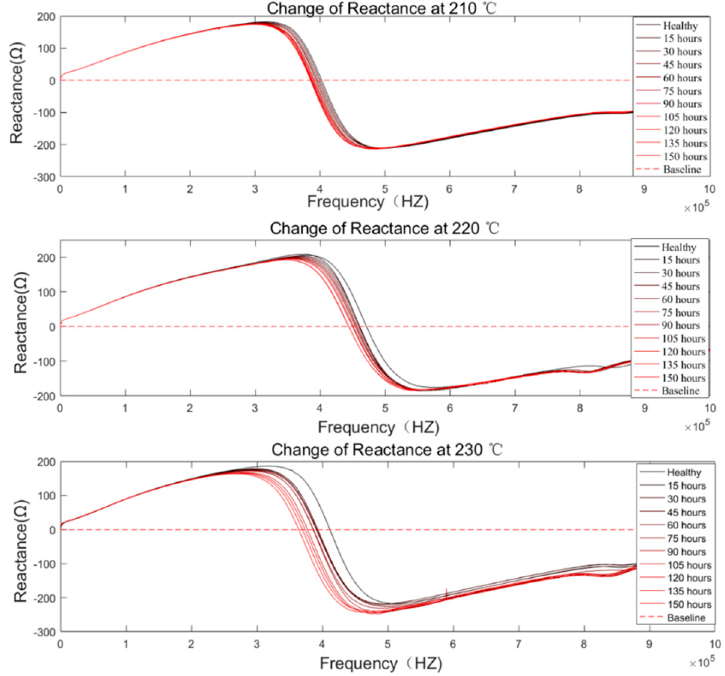
Figure 15. Reactance measurement results under 210 °C, 220 °C, and 230 °C.